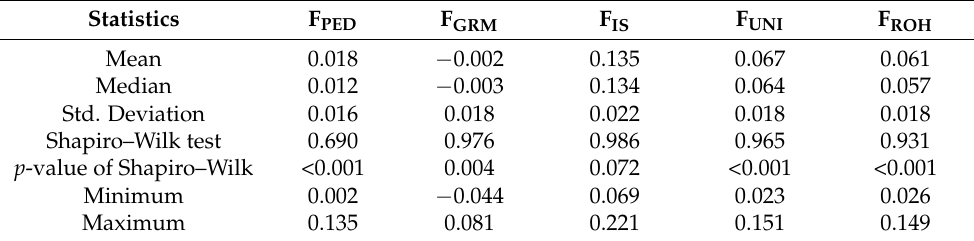
Table 2. Basic statistics for the analyzed inbreeding measures.